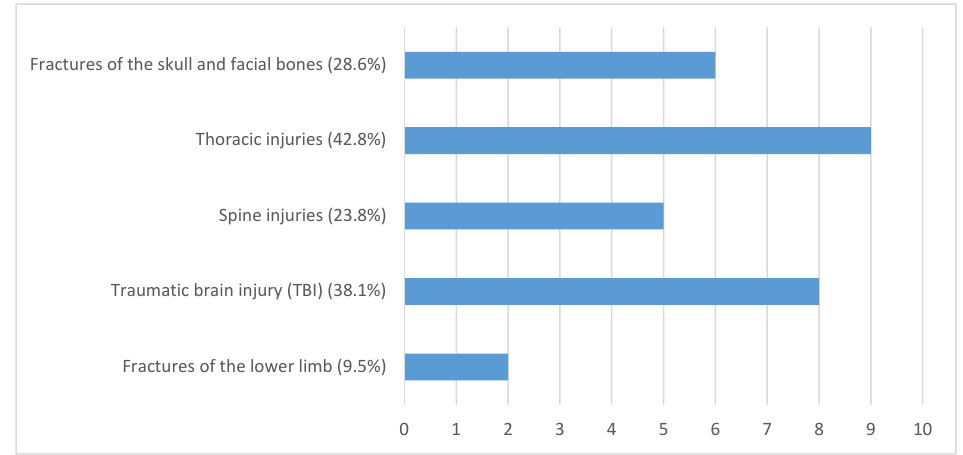
Figure 2. Concomitant injury detected through preoperative X-ray and computed tomography